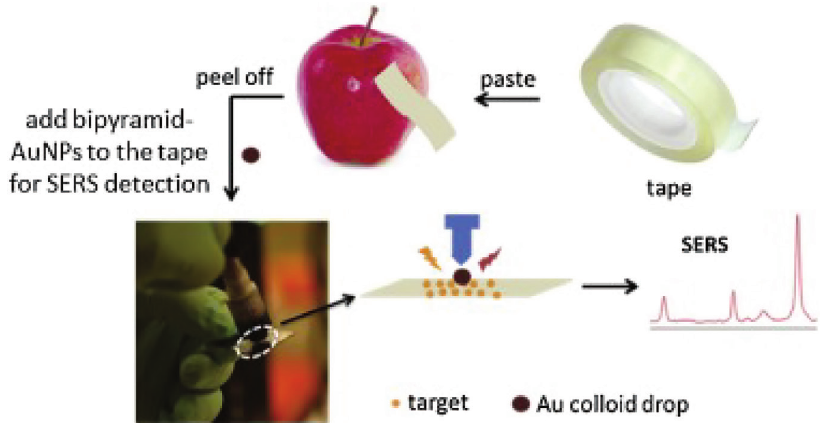
Figure 1: Schematic diagram of BP-AuNPs-based SERS tape sensor for trace sensing on peel surfaces Reprinted with permission from Ref.